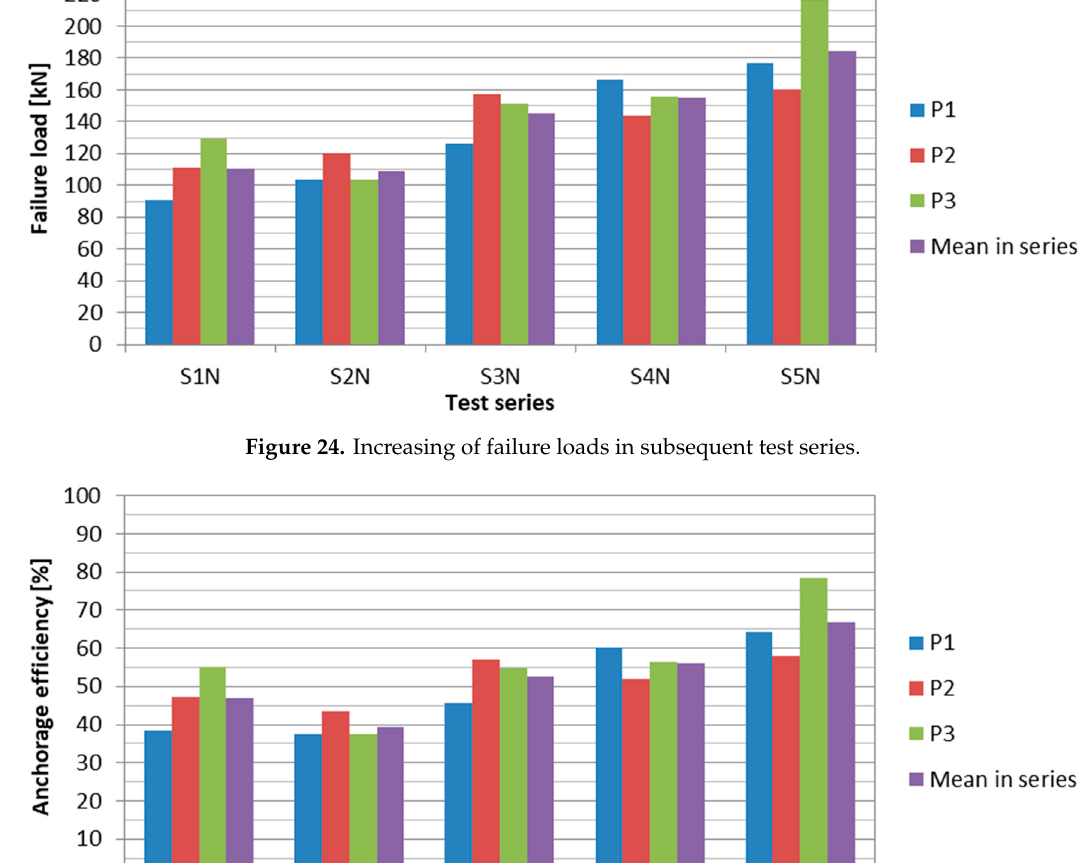
Figure 23. Load-displacement plots for the specimens with the maximum failure load in the subsequent series.